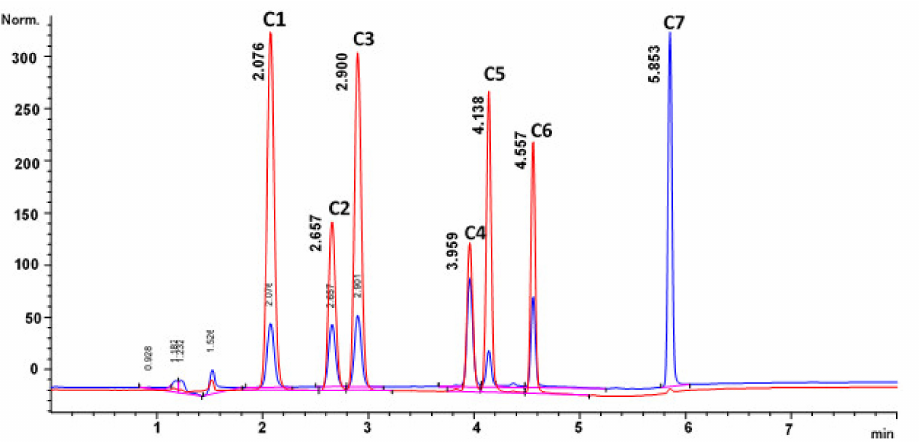
Figure 7. Separation of the C 1 –C 7 under optimised conditions using a gradient elution mode commencing at 0 min 25% B, 2 min 40% B, 3 min 65% B, 4 min 100% B with a run time of 6.5 min. Injection volume of 5 µ L, flow rate of 1.3 mL/min, and temperature of 25 ◦ C, at λ = 254 nm (blue) and λ = 331.4 nm